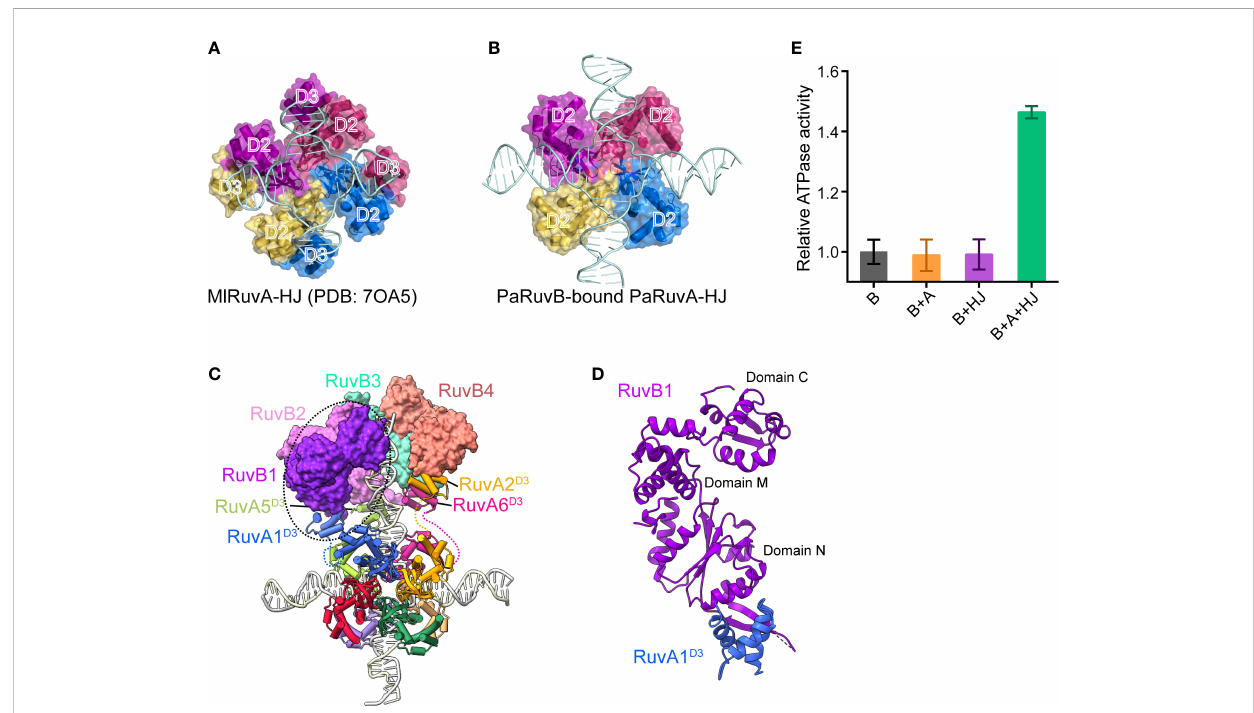
FIGURE 4 Recruitment and assembly of the RuvB motor. (A, B) Domain arrangement of RuvA in the crystal structure of MlRuvA-HJ complex (PDB: 7OA5) (A) and in the cryo-EM structure of RuvAB-HJ complex (B) . RuvA subunits are shown in surface with various colors. The RuvA D2 and RuvA D3 domains are labeled. Ml, Mycobacterium leprae; Pa, Pseudomonas aeruginosa . (C) Model of RuvAB-HJ complex. RuvB subunits are shown in surface and in different colors. RuvA subunits are shown in cartoon. HJ DNA is in ladder representation. (D) The interaction between PaRuvB (violet) and PaRuvA D3 (blue). (E) Measurements of RuvB ATPase activities in the presence of RuvA, HJ or both (mean ± s.d., n = 3 independent